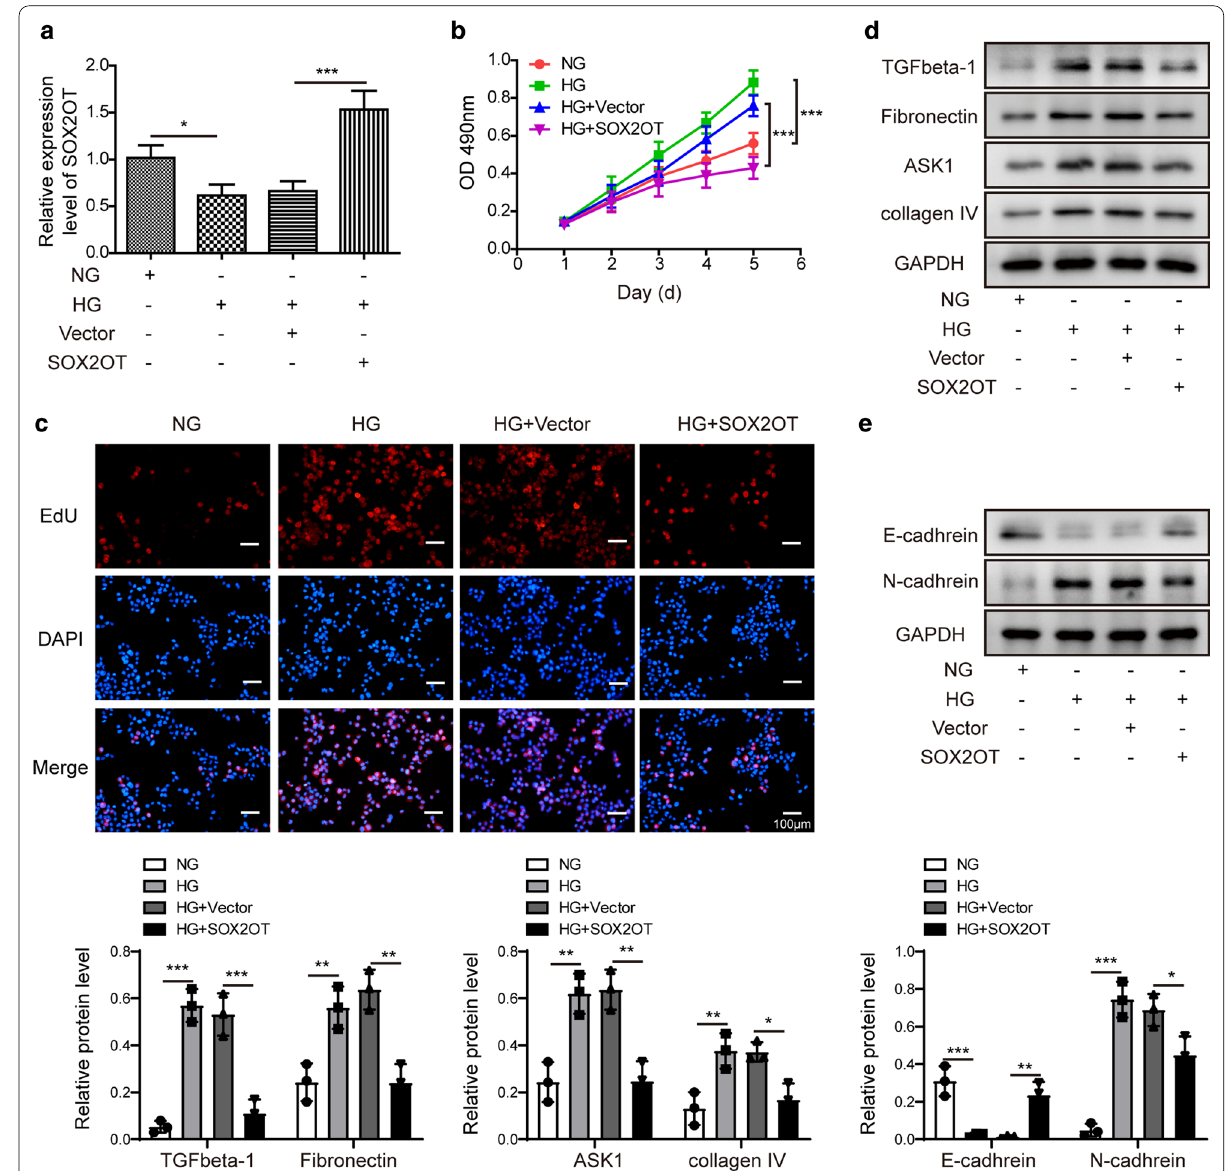
Fig. 3 SOX2OT overexpression inhibited mesangial cell proliferation and fibrosis. Mouse mesangial cells were incubated with high glucose (HG) or normal glucose (NG). HG cells were transfected with pcDNA-SOX2OT or pcDNA-vector. a mRNA expression of SOX2OT was detected by RT-qPCR in HG cells after SOX2OT overexpression. b Cell survival was measured using CCK-8 assay after SOX2OT overexpression. c EDU assay was performed to assess proliferation in HG cells after SOX2OT overexpression. d Western blot analysis of TGFβ-1, fibronectin, ASK1 and collagen IV in HG cells after SOX2OT overexpression. e Western blot analysis of E-cadherin and N-cadherin in HG cells after SOX2OT overexpression. GAPDH was used as a loading control in western blot analysis. Error bars represent the mean SD from three independent experiments. *p < 0.05, **p < 0.01, ***p < 0.001, ± One-way-ANOVA followed by Newman-Keuls post hoc